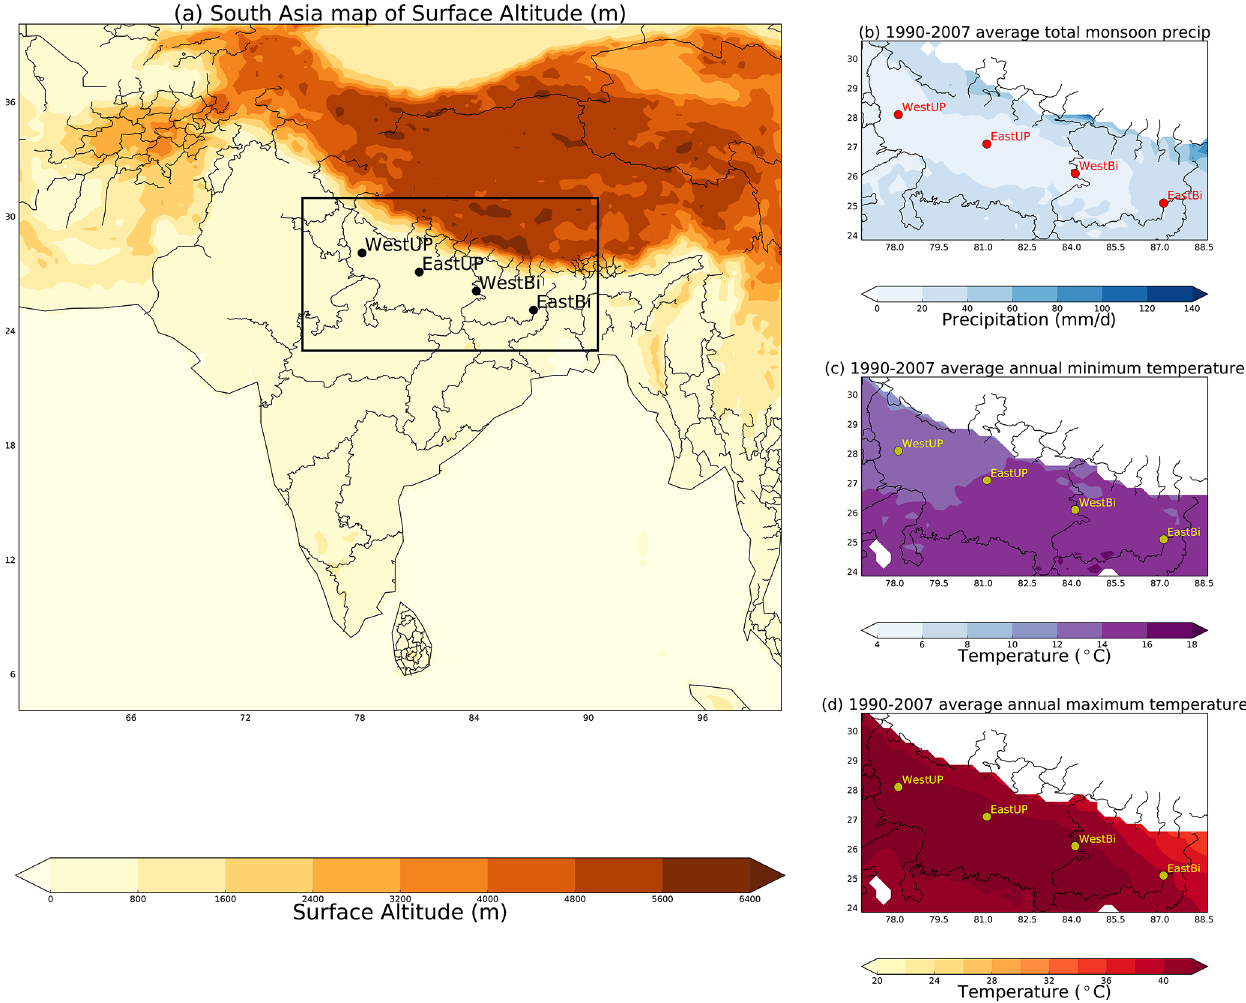
Figure 3. A map showing the location of the single-grid-box simulations in the wider context of India on a map of the surface altitude (a) from the regional climate model that is used in the JULES simulations. The same locations are shown in three smaller maps (b–d) that zoom in on the states of Uttar Pradesh and Bihar. The map in panel (b) shows the total monsoon precipitation, (c) shows the minimum temperature, and (d) shows the maximum temperature averaged for the period 1991–2007. Table 5. The sowing day of year (sowing DOY) and thermal times in degree days used in this study for the locations in Uttar Pradesh and Bihar, India (Fig. 3 for a map of the locations), the values given here are based on the observed sowing and harvest dates from Bodh et al.